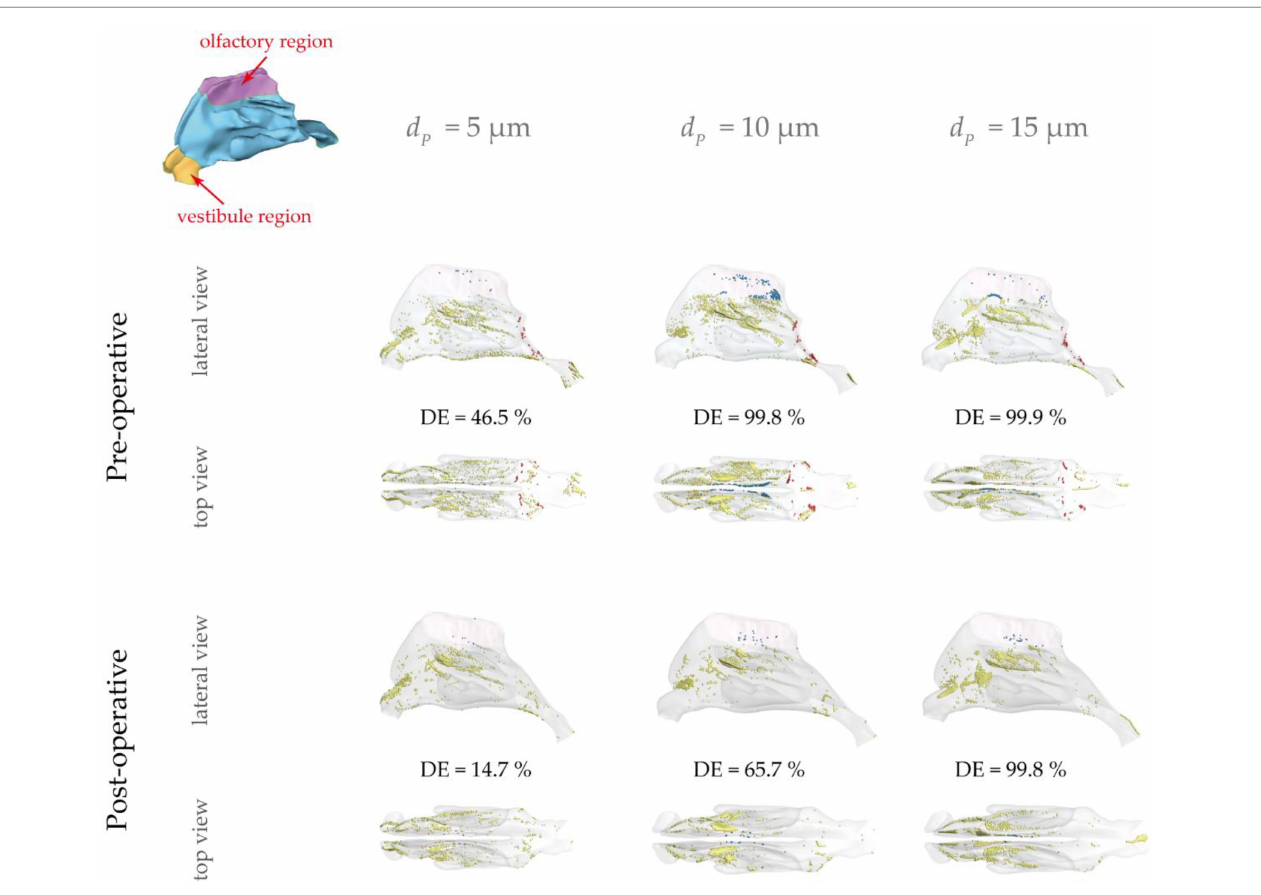
FIGURE 10 Micro-particle deposition patterns under 9.5 LPM pre- and post-operation with a particle diameter of 5 μ m, 10 μ m and 15 μ m. Patterns are colored based on particle deposition region and those trapped at the abnormal adenoid surface are highlighted by blue. Nasal surface is shown with 10%